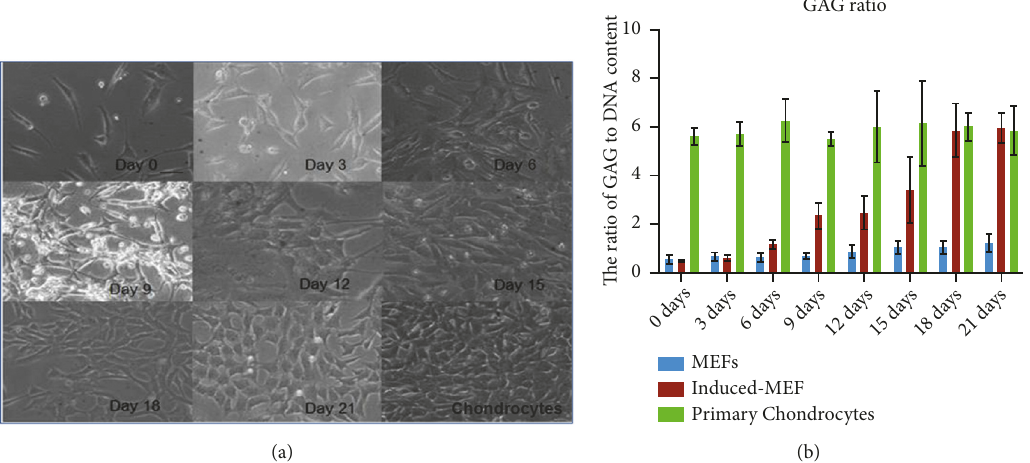
Figure 8: Morphology observation and GAG production: (a) Morphology of induced MEFs from day 0 to day 21 and primary chondrocytes; (b) GAG production of untreated MEFs (blue bar), induced MEFs (red bar), and primary chondrocytes (green bar) from day 0 to day 21.